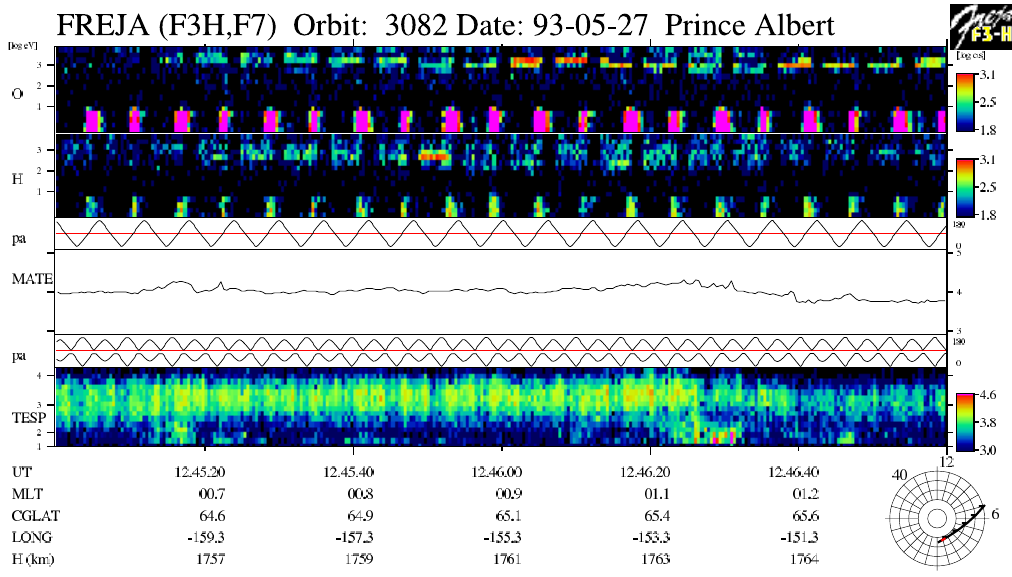
Fig. 7. A 2-min CSP for orbit 3082 showing generally more narrow energy spectra for O + ions than for H + .